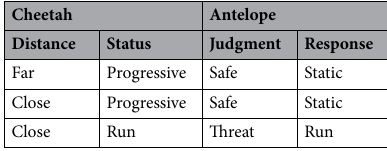
Table 1. Insensitive prey strategy.